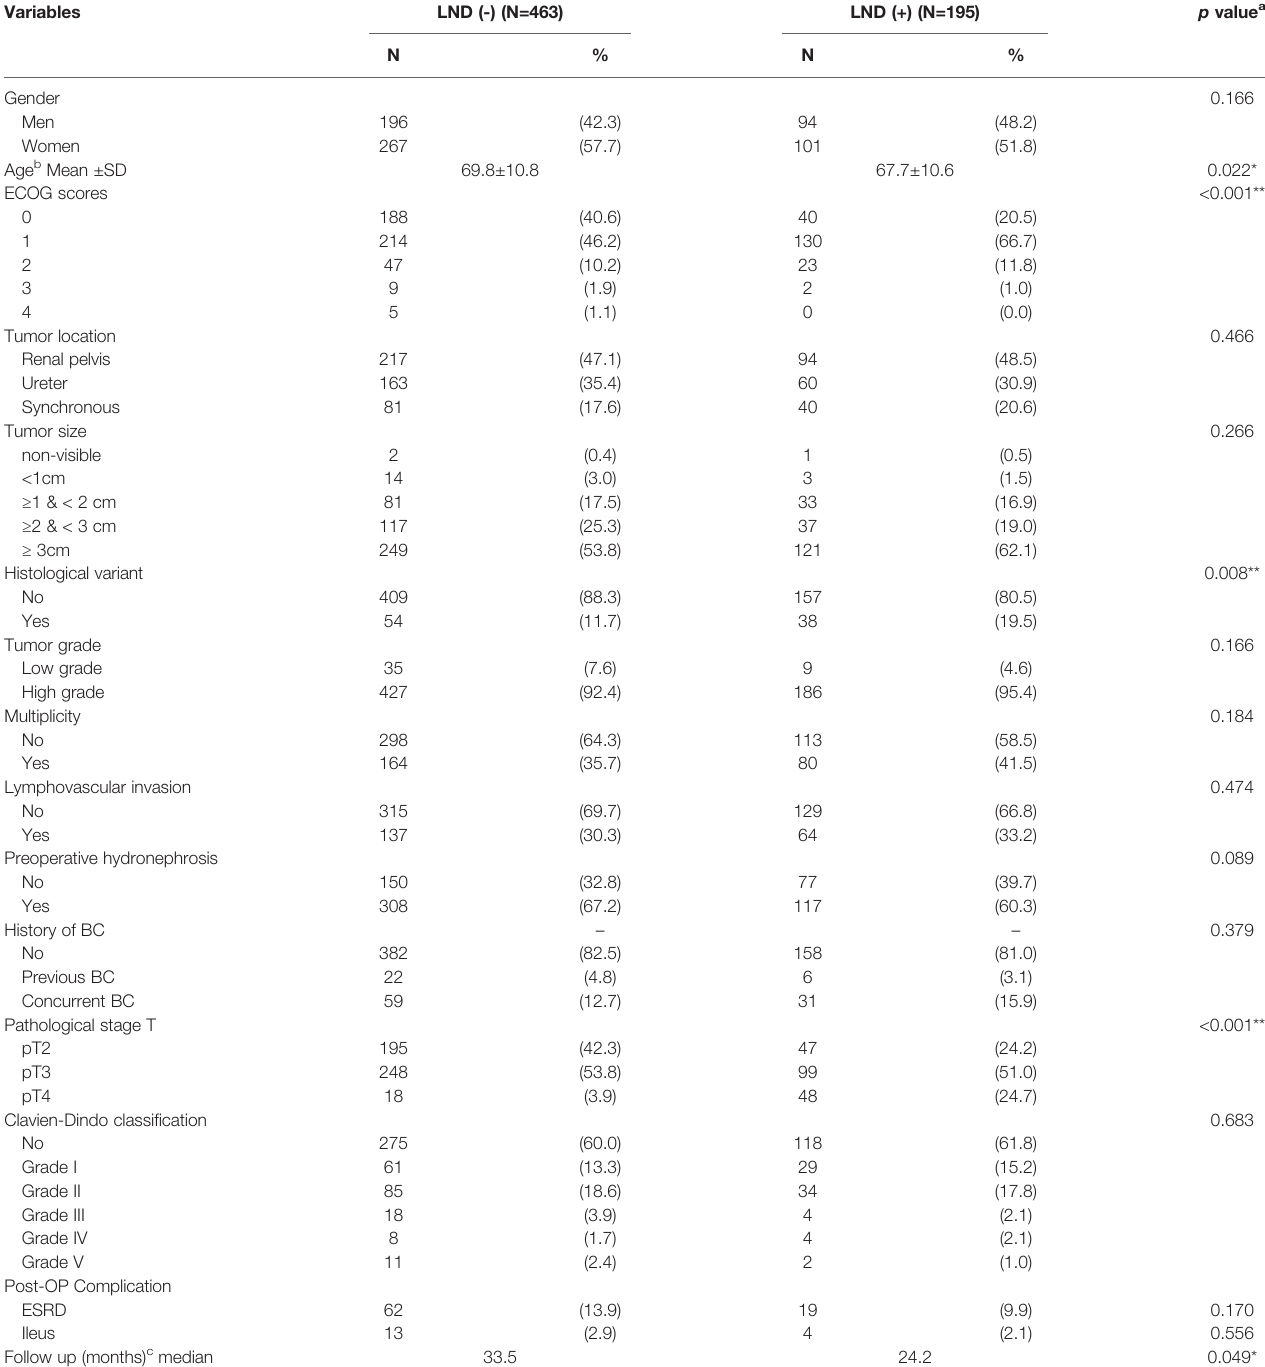
TABLE 1 | Clinicopathological data of cN0 UTUC patients receiving nephroureterectomy.